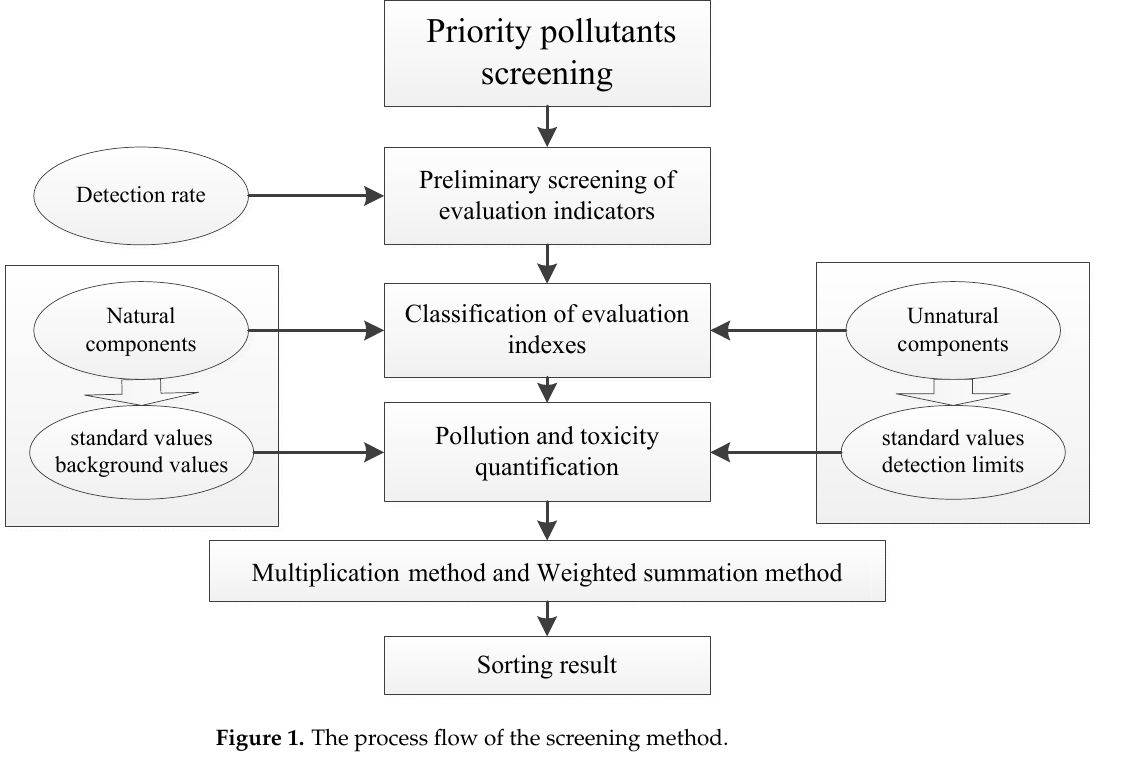
Figure 1. The process fl ow of the screening method.